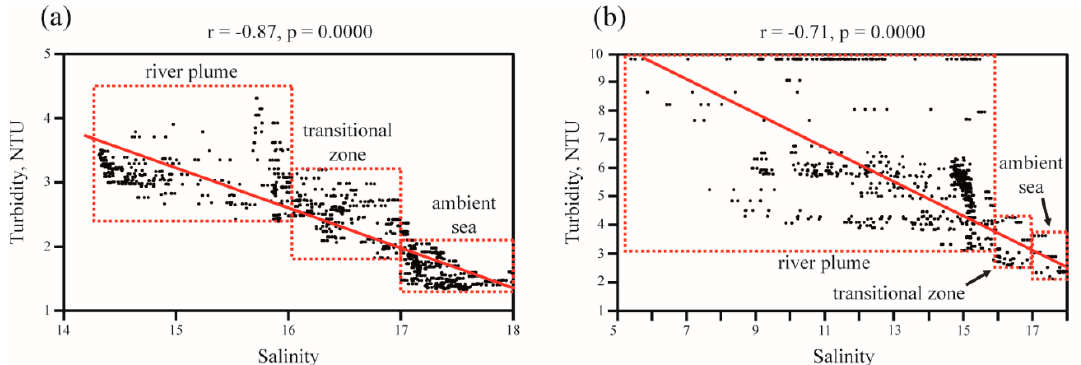
Figure 2. Relations between salinity and turbidity ( a ) within the Kodor plume and the adjacent saline sea on 2–3 April 2019 and ( b ) within the Bzyp plume and the adjacent saline sea on 31 May 2019. Dashed red boxes indicate river plumes, transitional zones, and ambient saline sea. Red lines indicate regression lines. The Pearson correlations coefficients ( r ) with p -values, which indicate statistical significance of the observed relations, are given above the diagrams.